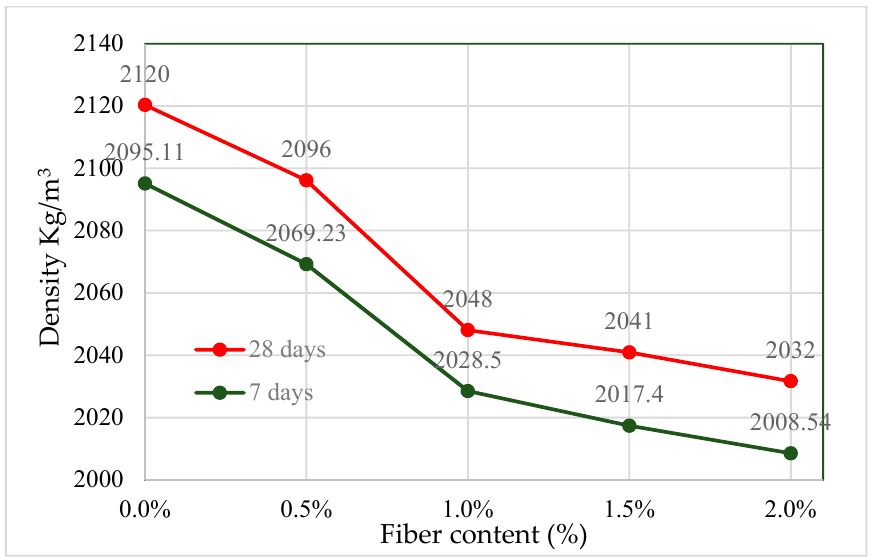
Figure 5. Effect of sisal fibers on the density of concrete.